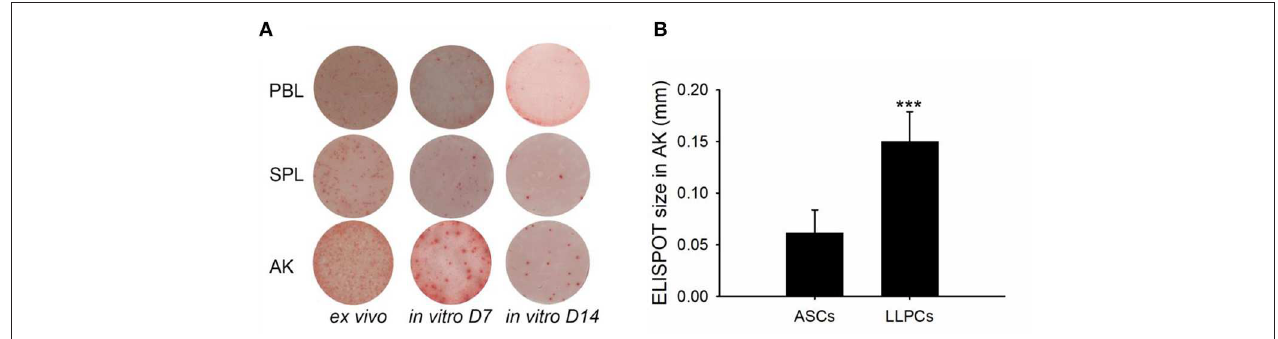
FIGURE 6 | LLPCs ( in vitro D15) have a strong capability to secrete antibodies compared to that of other ASCs (ex vivo and in vitro D7). ELISPOTs of TNP-specific ASCs from different immune tissues of vaccinated channel catfish 8 weeks post-immunization (2 × 10 6 leukocytes per well) (A) . The average ELISPOT size of AK LLPCs relative to ASCs ( ex vivo ). Statistical difference was evaluated by t -test, and *** p < 0.001 (B)